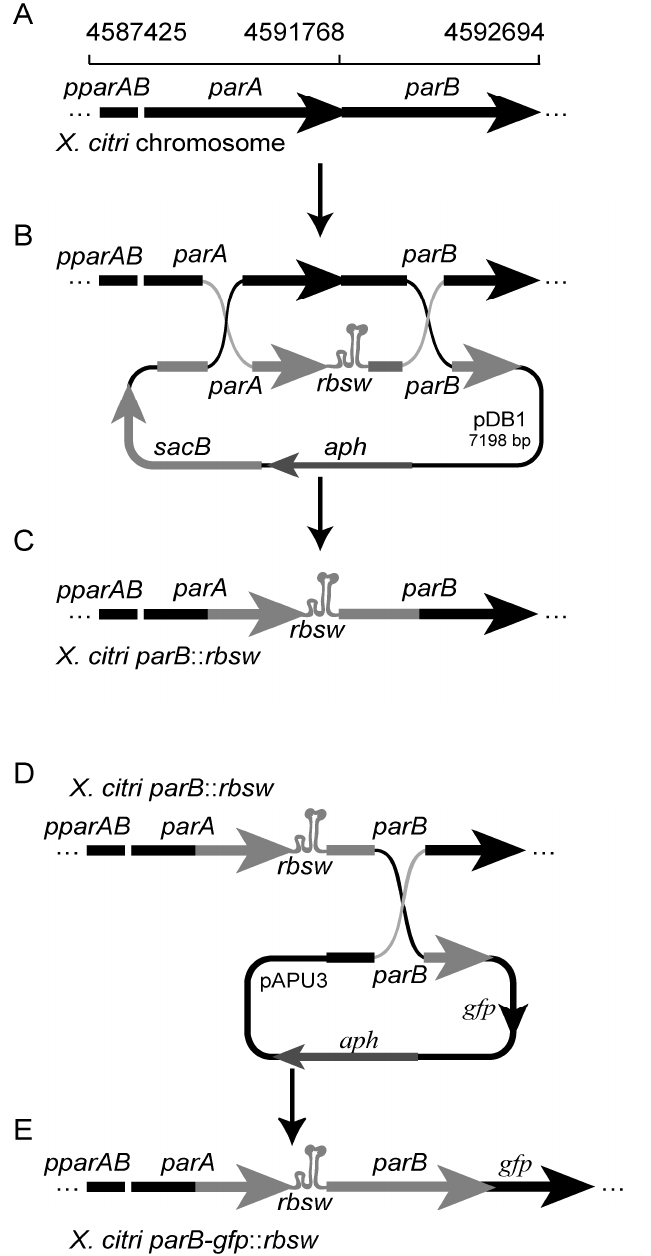
Figure 2. Schematic representation of the genomic region of X. citri carrying the riboswitch theo /metE and the mutant X. citri parB-gfp :: rbsw . ( A ) Structure and genomic coordinates of the parA B operon of X. citri strain 306. ( B ) The riboswitch theo /metE was inserted between the parA and parB genes by a double crossover between plasmid pDB1 and the bacterial chromosome, giving rise to the genomic structure shown in ( C ) for the strain X. citri parB :: rbsw . ( D ) The double crossover between plasmid pAPU3 and the chromosome of X. citri parB :: rbsw , giving rise to the genomic structure shown in ( E ) for the strain X. citri parB-gfp :: rbsw , in which the expression of ParB-GFP can be modulated by the riboswitch theo /metE .